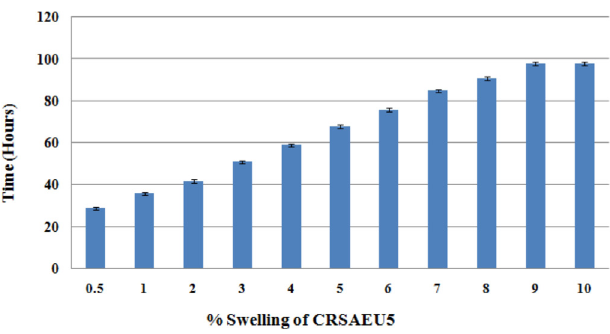
FIGURE 2 - % swelling studies of formulation CRSAEU5 ±S.D,